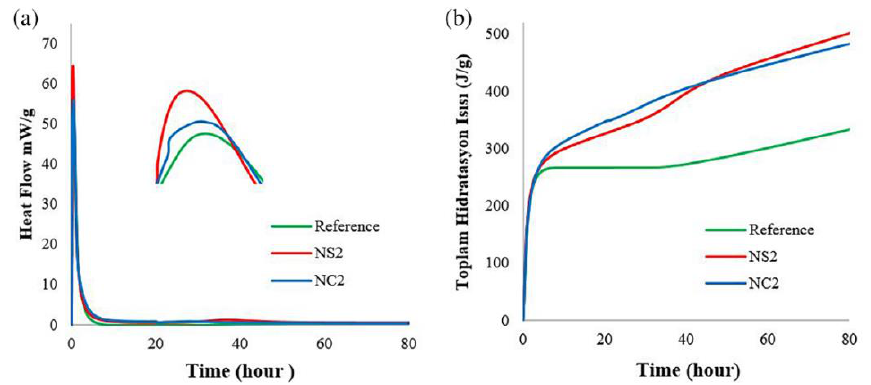
Figure 12. Hydration rate curve and cumulative heat of hydration of geopolymer slurry at 90 °C [69]. ( a ) Rate of hydration at 90 °C, ( b ) Total heat hydration at 90 °C.